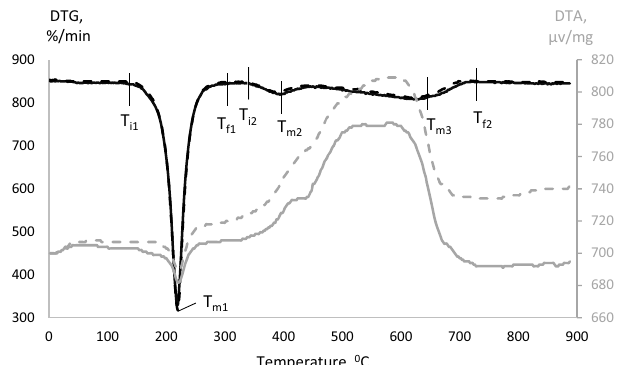
Figure 3. Thermal gravimetric graphs and differential thermal analysis graphs for a sample of PVC film containing purified ST cadmium yellow before (black line) and after (black dashed line) UV irradiation.